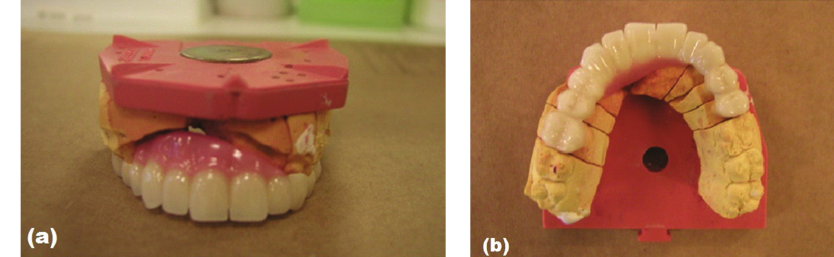
Figure 5: Framework of zirconia-based prosthesis modified with gingival colored